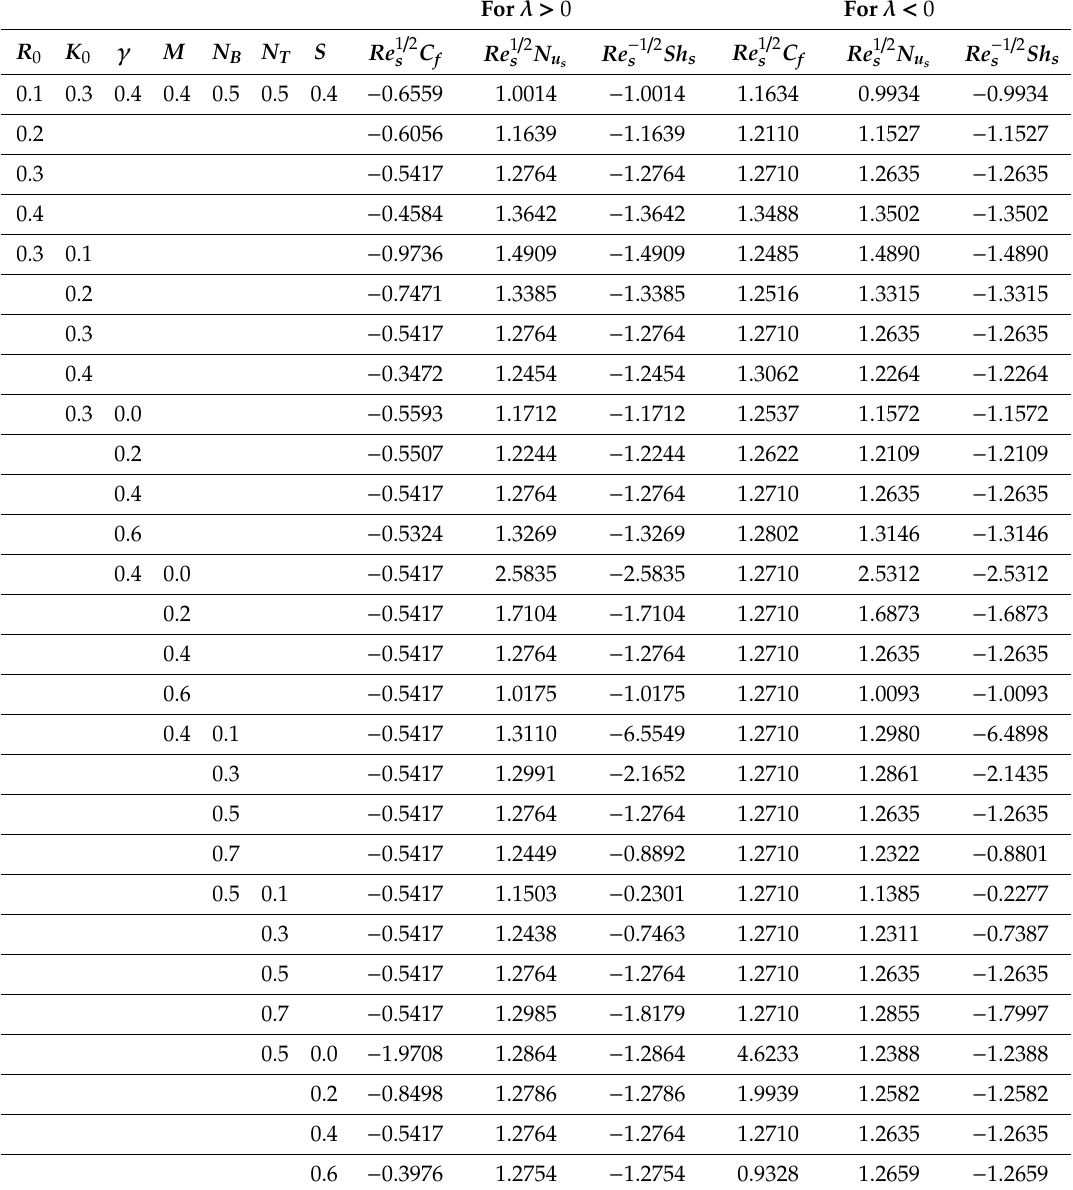
− 1/2 , and Re s Sh s s